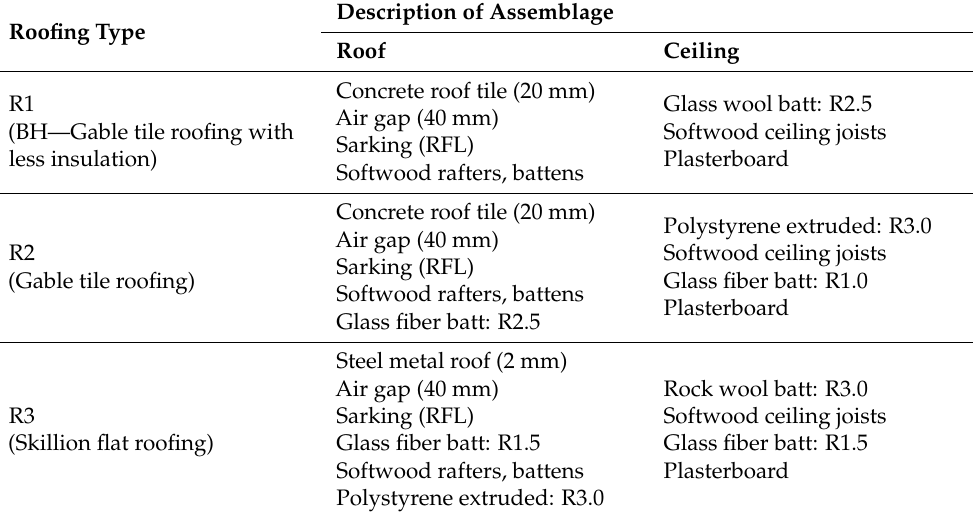
Table 6. Description of different roofing (roof + ceiling) assemblages.